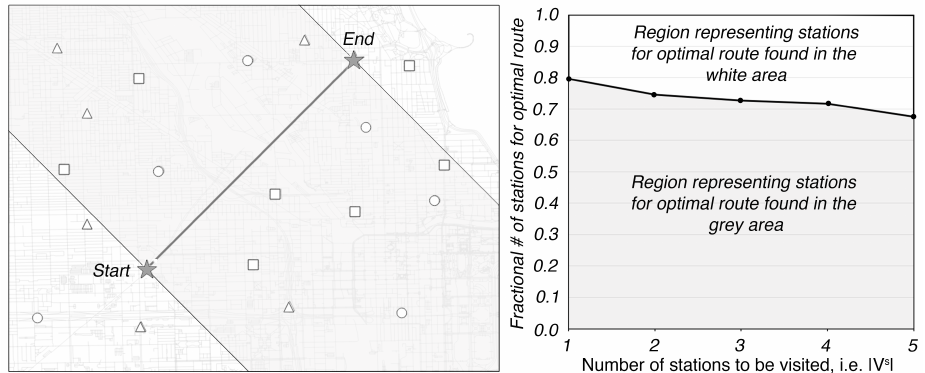
Figure 6. Possible explanation of the out-performance of R-Search for increased complexity. It can be seen that the total number of optimal stations within the white region increases with increase in the complexity of the model ( left plot ). Since R-Search also selects optimal stations from the white region, it performs better for higher | V s | instances ( right plot